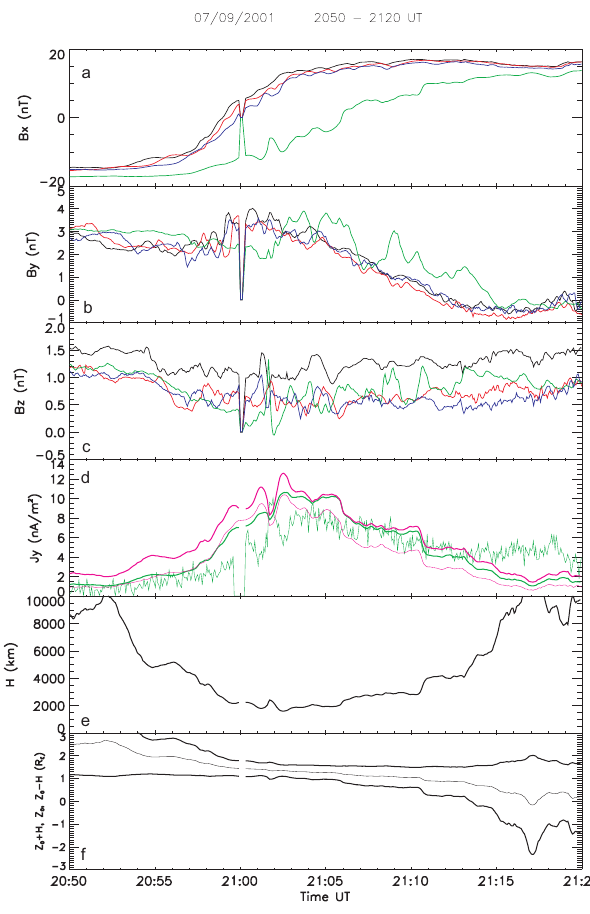
Fig. 10. Quiet CS crossing. Notice that B y and B z are not at the same scale as B x ; most of the magnetic field variations are on B x , as expected for a 1-D CS. Panel (d) shows (i) Harris current density at the equator (thick pink line), (ii) at the location of S/C 3 (thick green line), (iii). J y from curlB (thin pink line) and (iv) contribution of ions to J y , computed from CIS measurement on S/C 3 (thin green line); panels (e) and (f) show the half- thickness ( H ) of the CS and the location of its center ( Z 0 ). Time resolution is